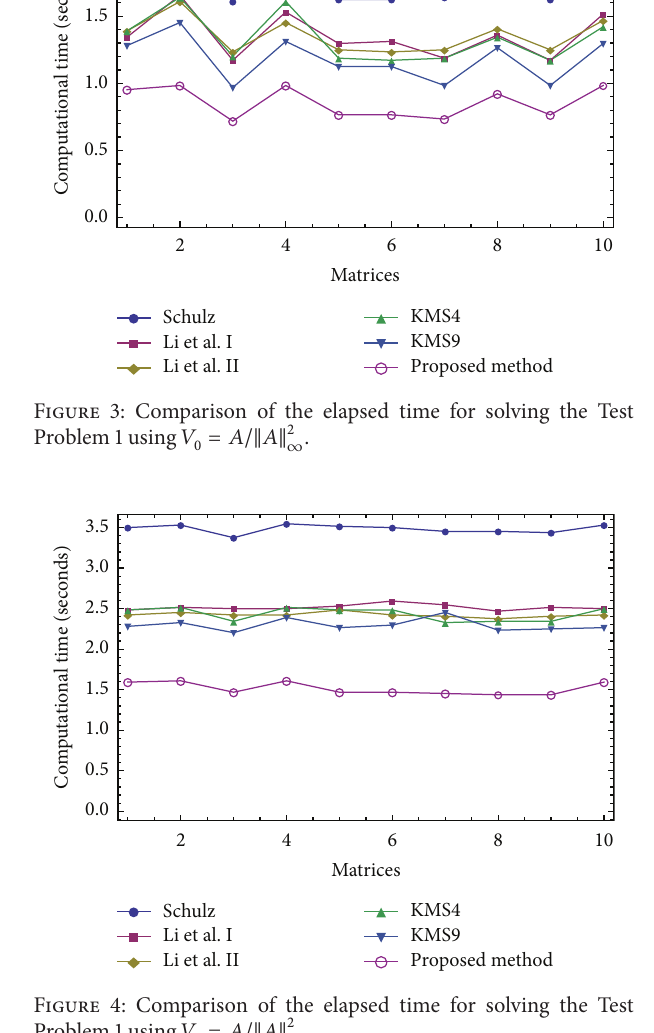
Figure 2: Comparison of the elapsed time for solving the Test Problem 1 using 𝑉 0 = 𝐴/‖𝐴‖ 2 1 .